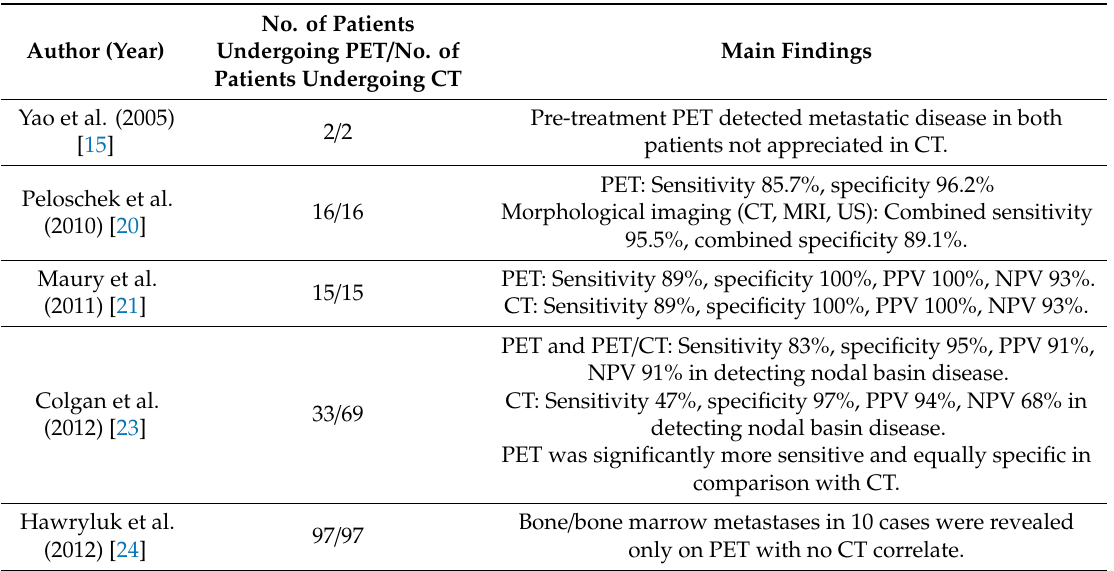
Table 2. Summary of the published studies (including > 1 patient) presenting a direct comparison between 18 F-fluorodeoxyglucose ( 18 F-FDG) PET or 18 F-FDG PET / CT and CT in Merkel cell carcinoma (in chronological